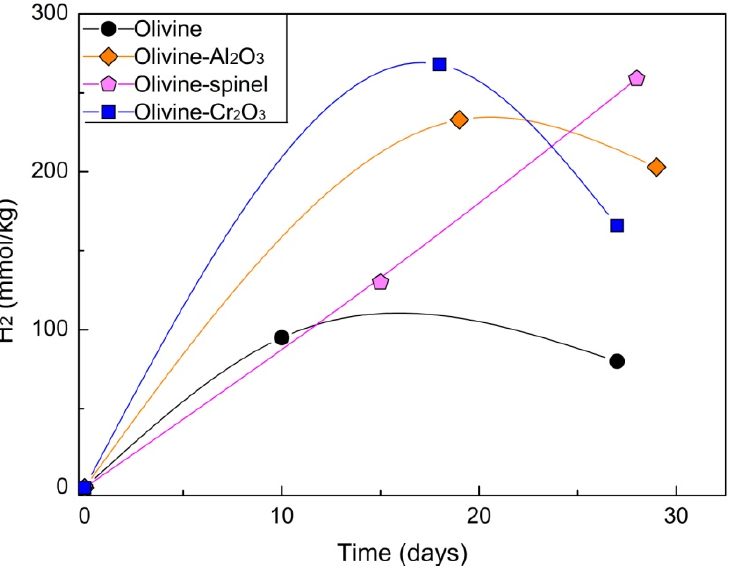
Figure 3. The concentrations of H 2 in aqueous fluids (mmol/kg) for experiments at 311 °C and 3.0 kbar as a function of experimental durations (in day), showing that spinel, aluminum and chromium accelerate the production of H 2 during serpentinization.